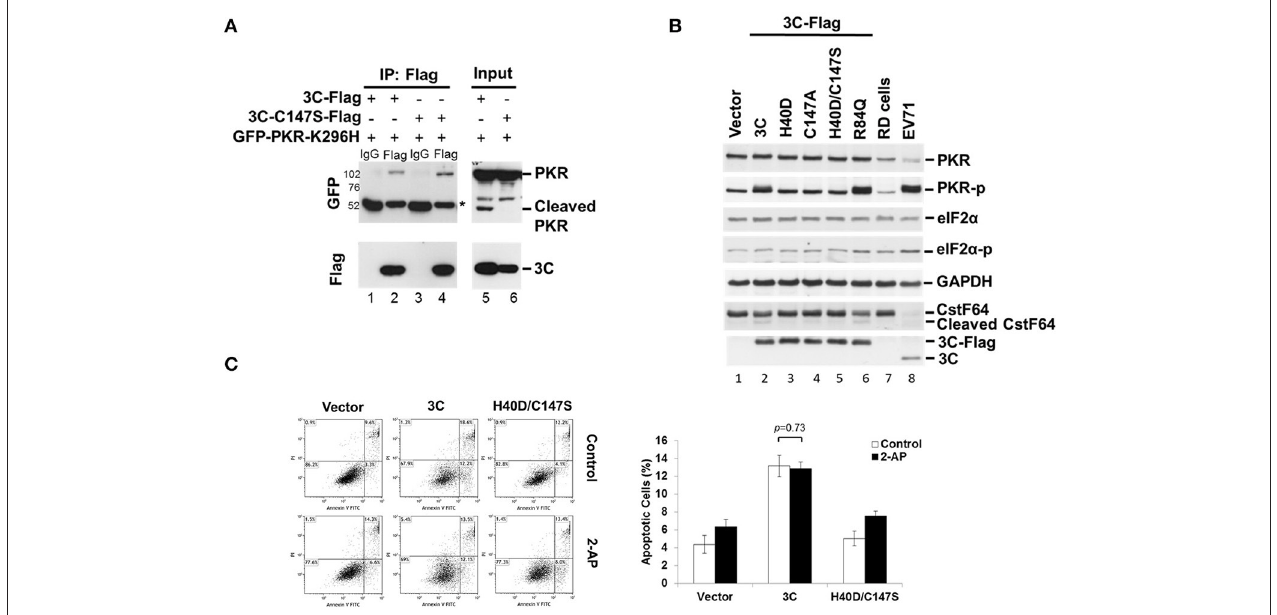
FIGURE 4 | EV-A71 3C associates with PKR and induces PKR phosphorylation. (A) The 293T cells were cotransfected with plasmids encoding GFP-PKR-K296H and 3C-Flag, or 3C mutant C147S-Flag, and then harvested at 24 h post-transfection. The cell lysates were immunoprecipitated with antibody against Flag. Samples were then subjected to western blot analysis with detection using anti-GFP and anti-Flag antibodies. *Denotes the heavy chains. (B) Mutations of the protease catalytic sites H40 and C147 of 3C caused loss of the PKR phosphorylation activity. RD cells were either transfected with 3C-Flag, H40D, C147S, H40D/C147S, or R84Q, for 24 h or infected with EV-A71/2231 at an m.o.i. of 10 for 8 h. Cellular extracts were collected and immunoblotting was performed for detecting PKR, PKR-p, eIF2 α , eIF2 α -p, CstF64, Flag, and viral 3C expression levels. CstF64 cleavage was used as a control for 3C catalytic activity. A representative result from three independent experiments is shown. (C) The PKR inhibitor 2-AP has no effect on 3C-induced apoptosis. The 3C- or H40D/C147S-transfected 293T cells were incubated with or without 2-AP for 24 h and then analyzed for apoptosis by flow cytometry using Annexin V and PI staining. The values shown in the lower left, lower right, and upper right quadrants of each panel represent the percentage of viable, apoptotic, and dead cells, respectively. Data are the means ± SD of values from three independent experiments.